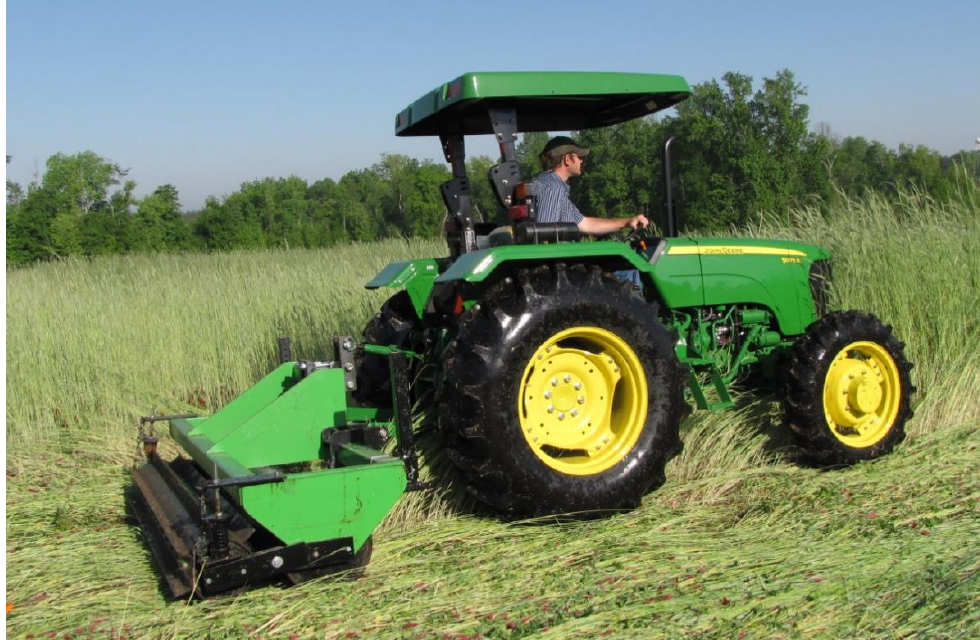
Figure 3. Side view of the experimental patented two-stage roller/crimper with two adjustable compression springs to set crimping force of the secondary crimping drum.